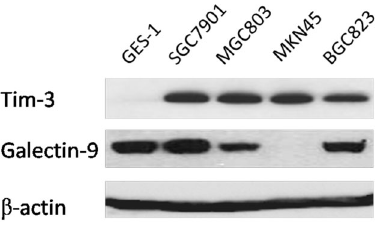
Figure 2. The Western blotting results of cell lines were consistent with the Immunohistochemical analysis of gastric cancer tissues. Note that both Tim-3 and Gal-9 were detected in gastric cancer cell lines MGC803,SGC7901, and BGC823, absence of Gal- 9 activation in MKN45 cells, and negative of Tim-3 immunostaining in GES-1 were also confirmed.